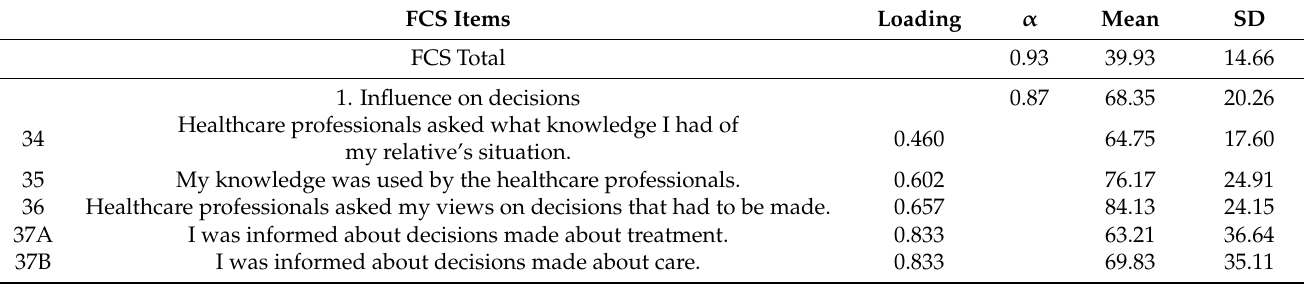
Table 2. Summary statistics of the confirmatory factor analysis model of the Swedish FCS ( n =